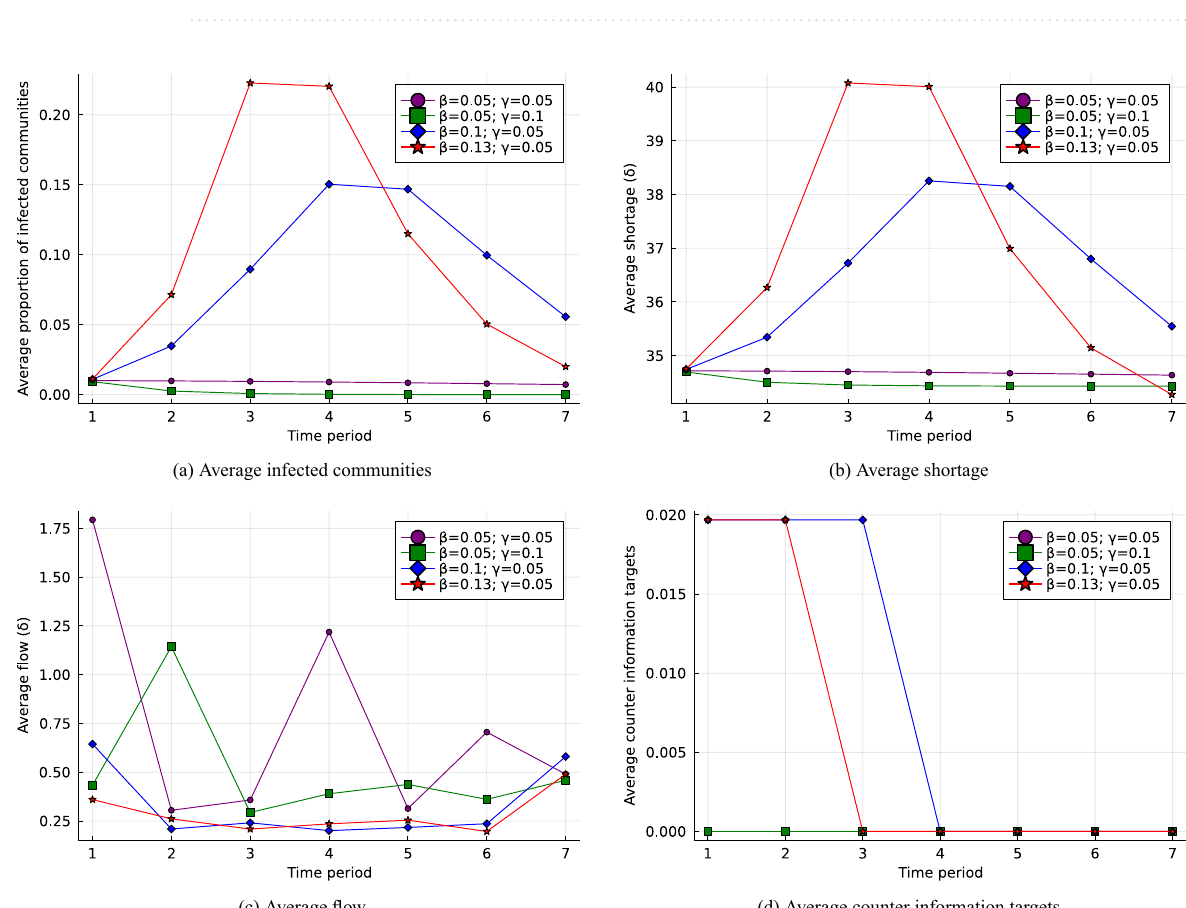
Figure 3. Time series of ( a ) average infected communities, ( b ) average shortage, ( c ) average flow, and ( d ) average counter information targets, with different combinations of β and γ . Note the relationship to particular points in Fig. 2 denoted by